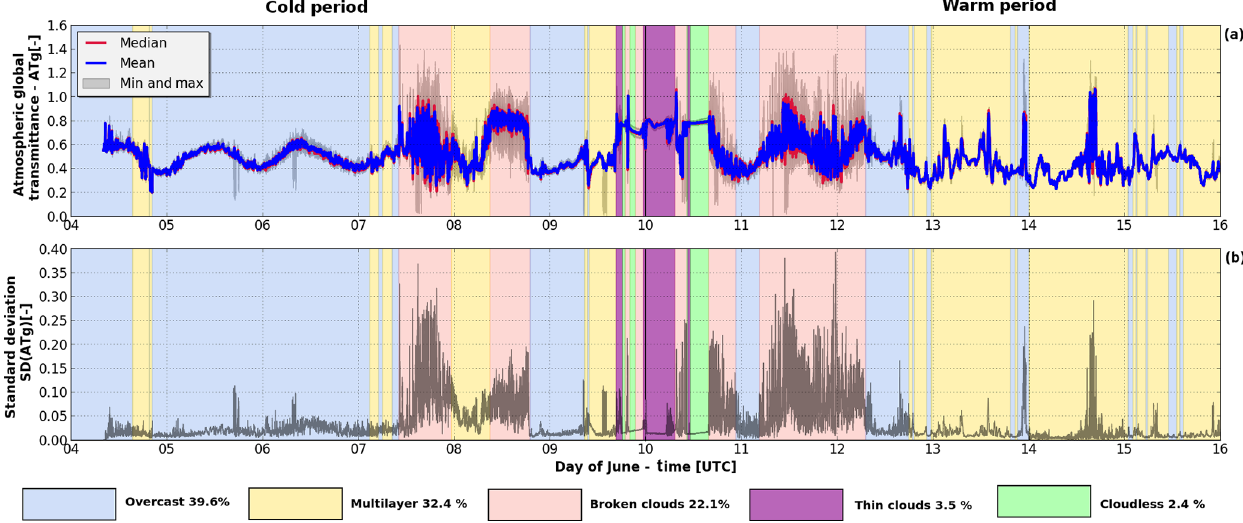
Figure 4. (a) Time series of atmospheric global transmittance (ATg) derived from the pyranometer network. (b) Time series of the inter- station standard deviation of